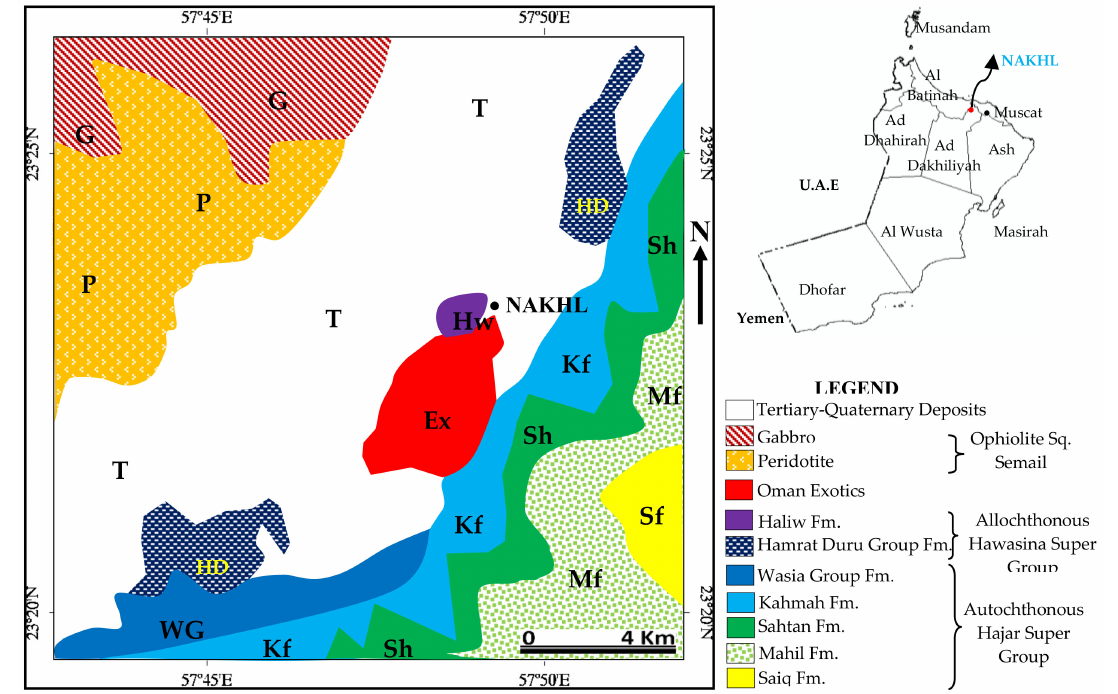
Figure 1. Geology of Nakhl region (Source: Geological map of the Oman Mountains, KSEPL,